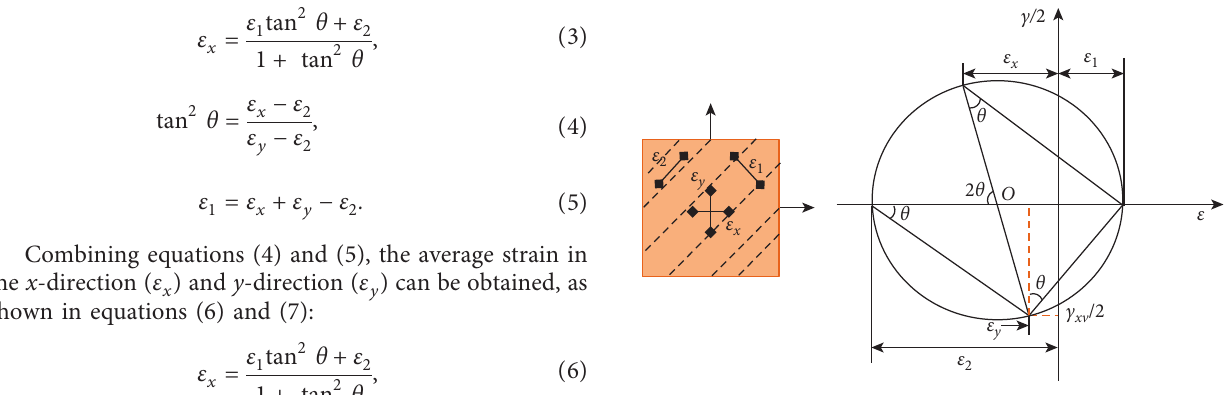
Figure 1: Mohr’s circle for average